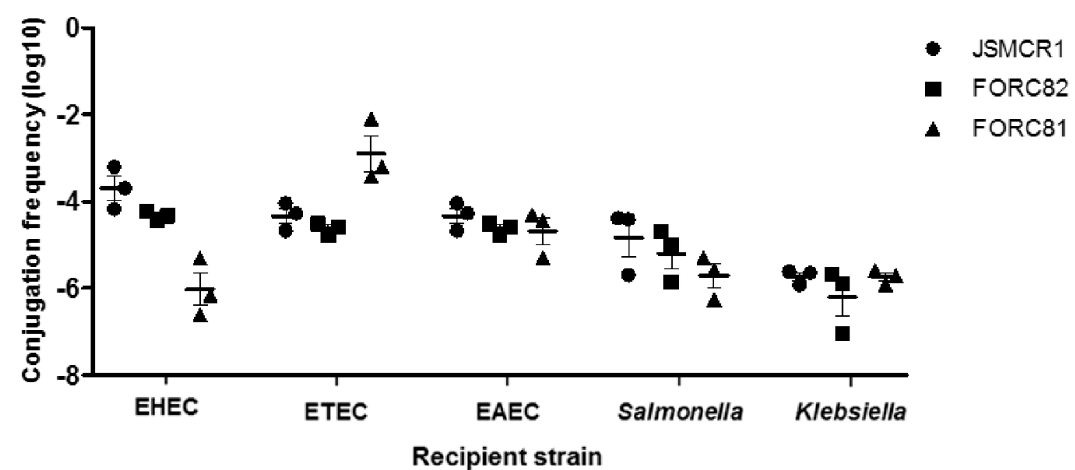
Figure 2. Conjugation frequencies of three mcr-1 plasmids from E. coli isolates from retail chicken. The data represent the means and standard deviations of the results from three independent experiments.